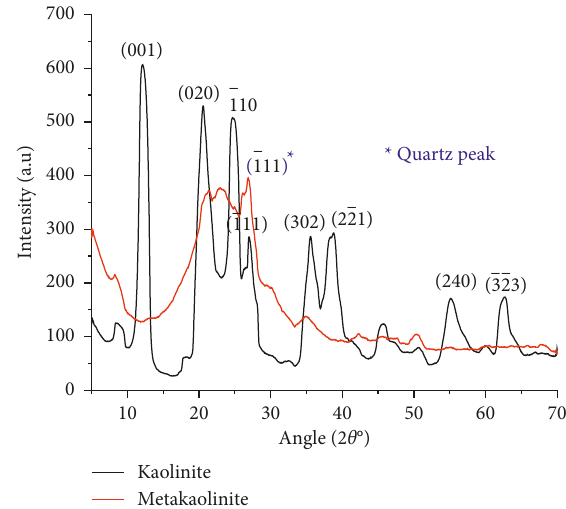
Figure 3: (a) XRD diffraction peaks of kaolinite and metakaolinite (calcined kaolinite).